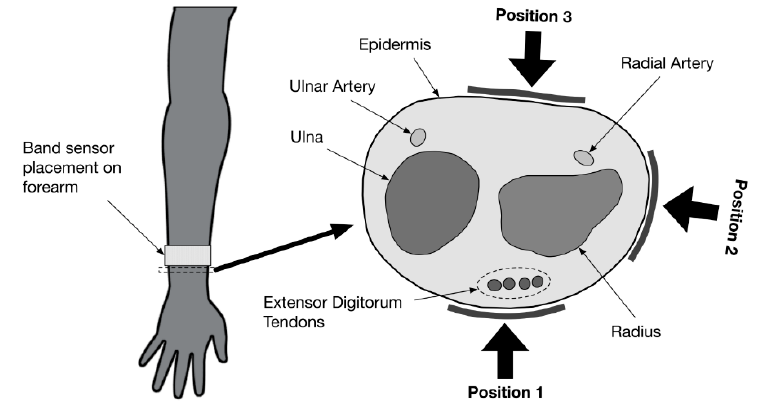
Figure 6. Cross-section schematic of the wrist area (extensor retinaculum/distal forearm) showing the band sensor mounting position for posterior ( P1 ), radial ( P2 ), and anterior ( P3 ) mounting.